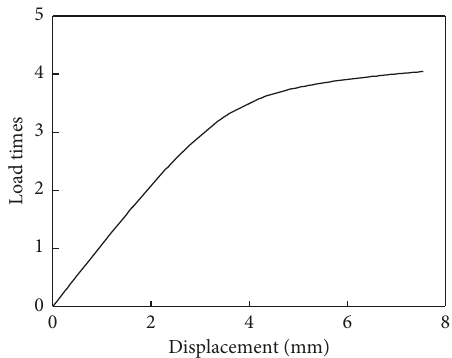
Figure 8: The load times-displacement curve.